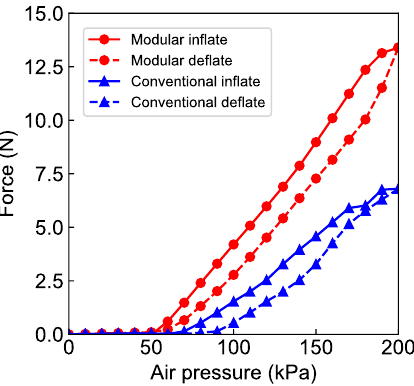
Figure 8. Tip force of modular and conventional soft